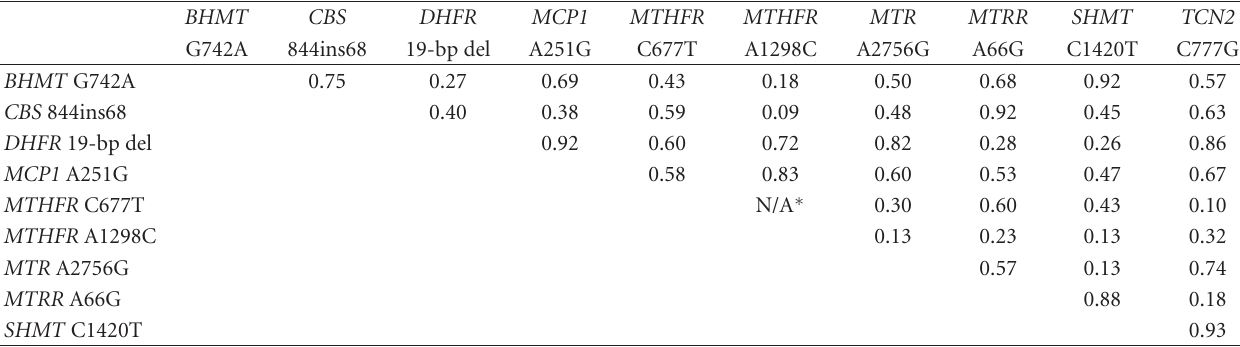
Table 2: MDR-P results (adjusted P values) for all 2-locus models of the inherited genotype and CTRD, Children’s Hospital of Philadelphia, 1997–2007.